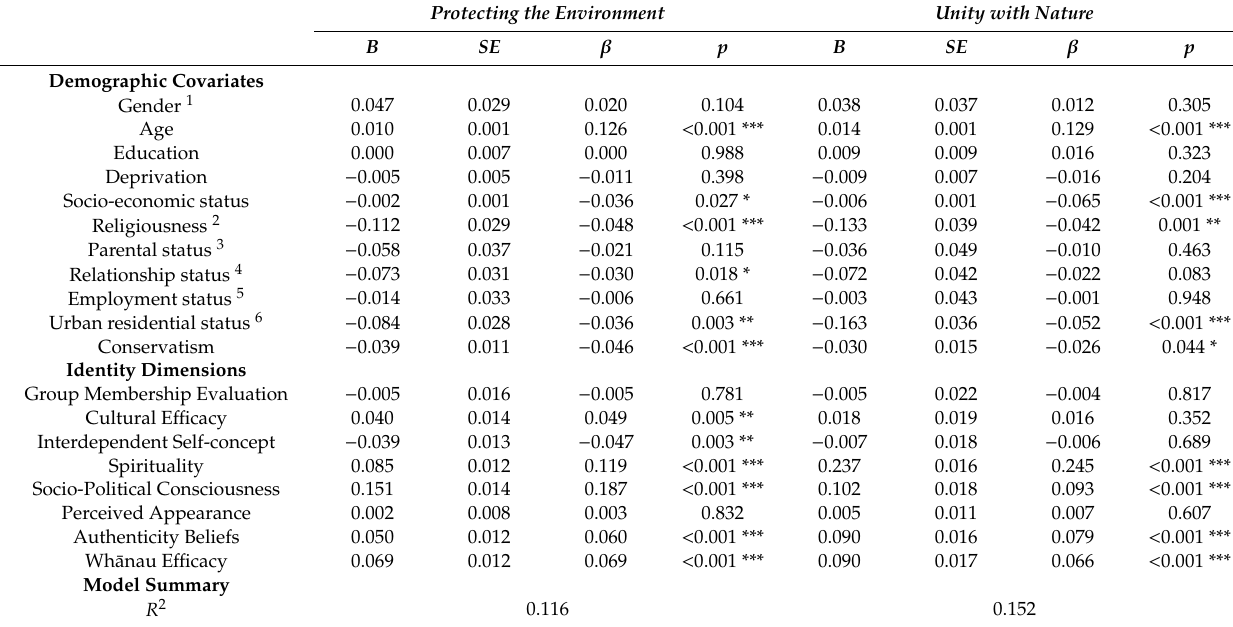
Table 2. Summary of simple regression analyses for variables predicting value of protecting the environment and unity with nature (N = 6812). Protecting the